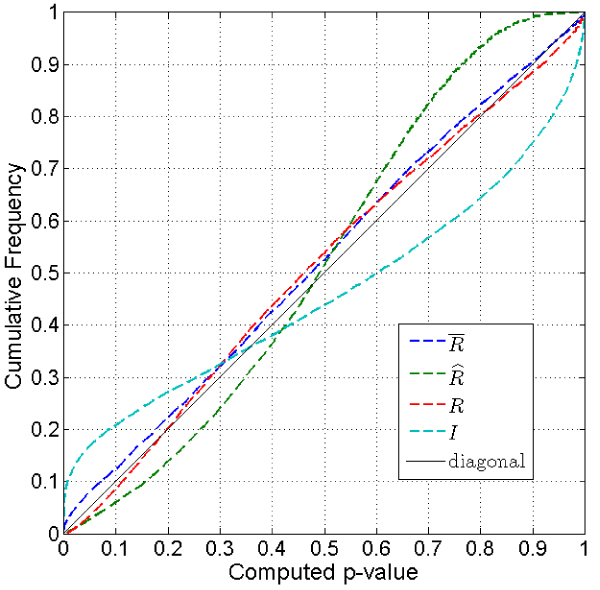
Cumulative distribution of p-values for two-sided test case with sample size n = 5. P-values calculated from random samples based on  (blue line) gives a reliable correction, which is comparable with the p-values from the true correlation R (red line).